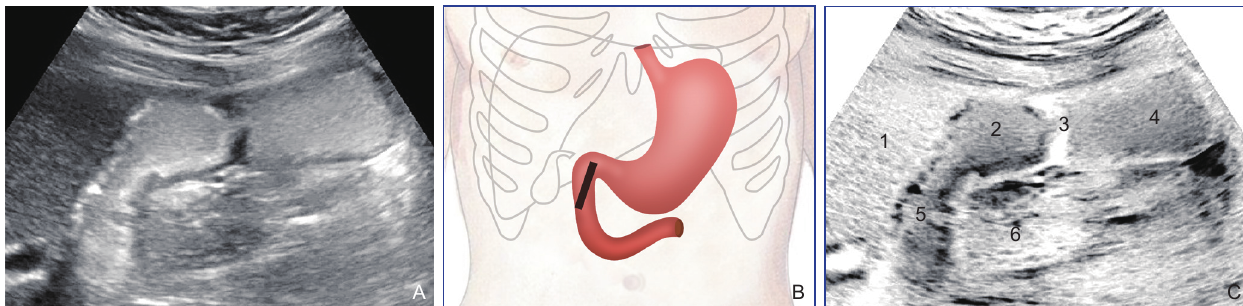
Figure 16 Ultrasonogram and schematic diagram of the long axis section of descendent duodenum (scan through the right upper abdomen) 。 A, Ultrasound image; B, Scan the schematic diagram; C, Ultrasound schematic diagram (1, Right liver lobe; 2, Duodenal bulb; 3, Pylorus; 4, Gastric antrum; 5, Descendent duodenum; 6, Head of